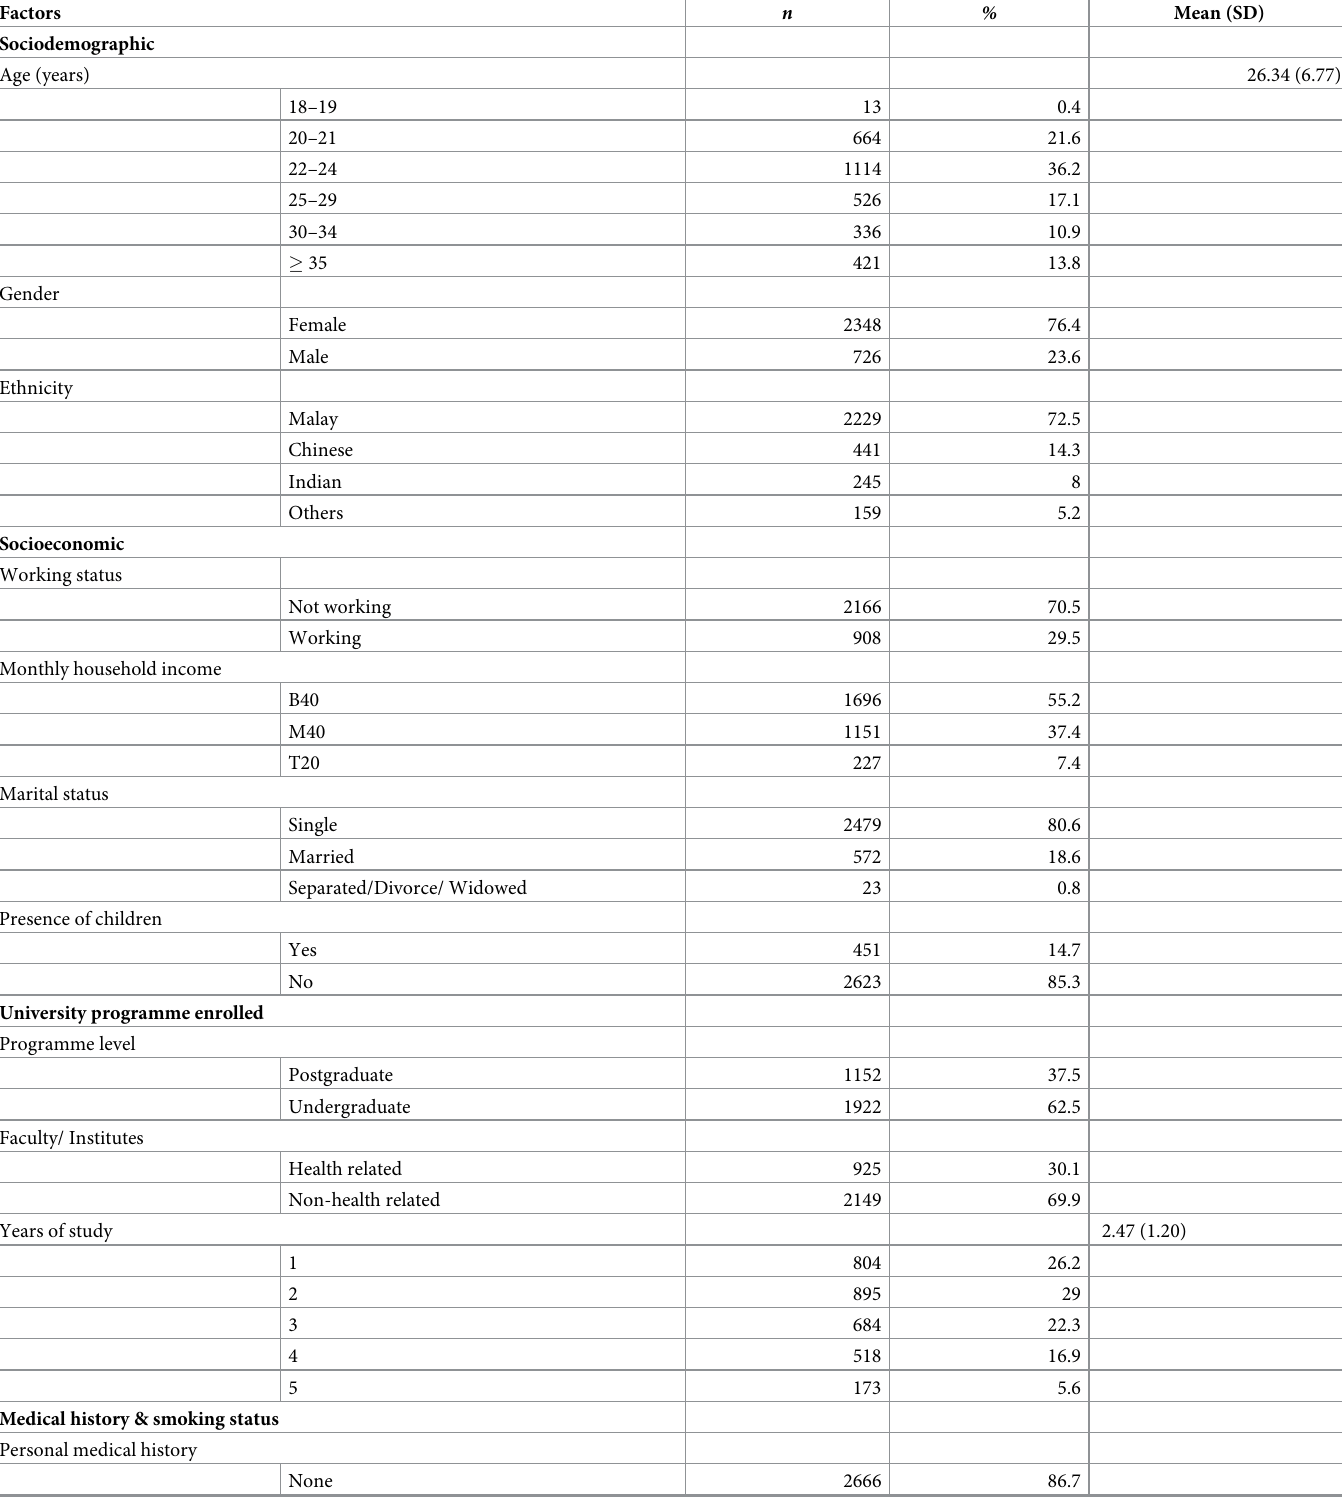
Table 1. Characteristic of the university students attending a public university in Klang Valley, Malaysia ( n = 3074).